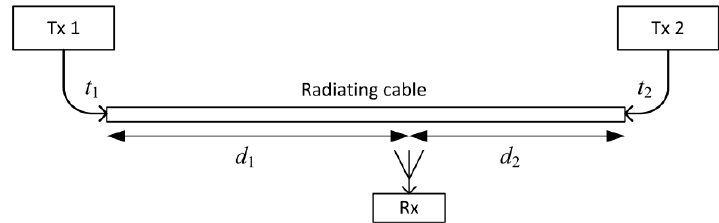
Figure 1. Principle of position estimation along the radiating cable using the time difference of arrival (TDOA) method.